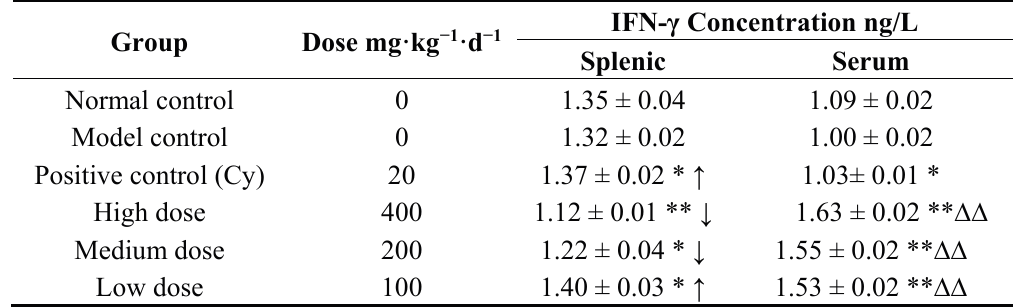
Table 6. Effects of BBP3-1 on immune factors IFN- γ in lymphocytes ( x ± s, n =